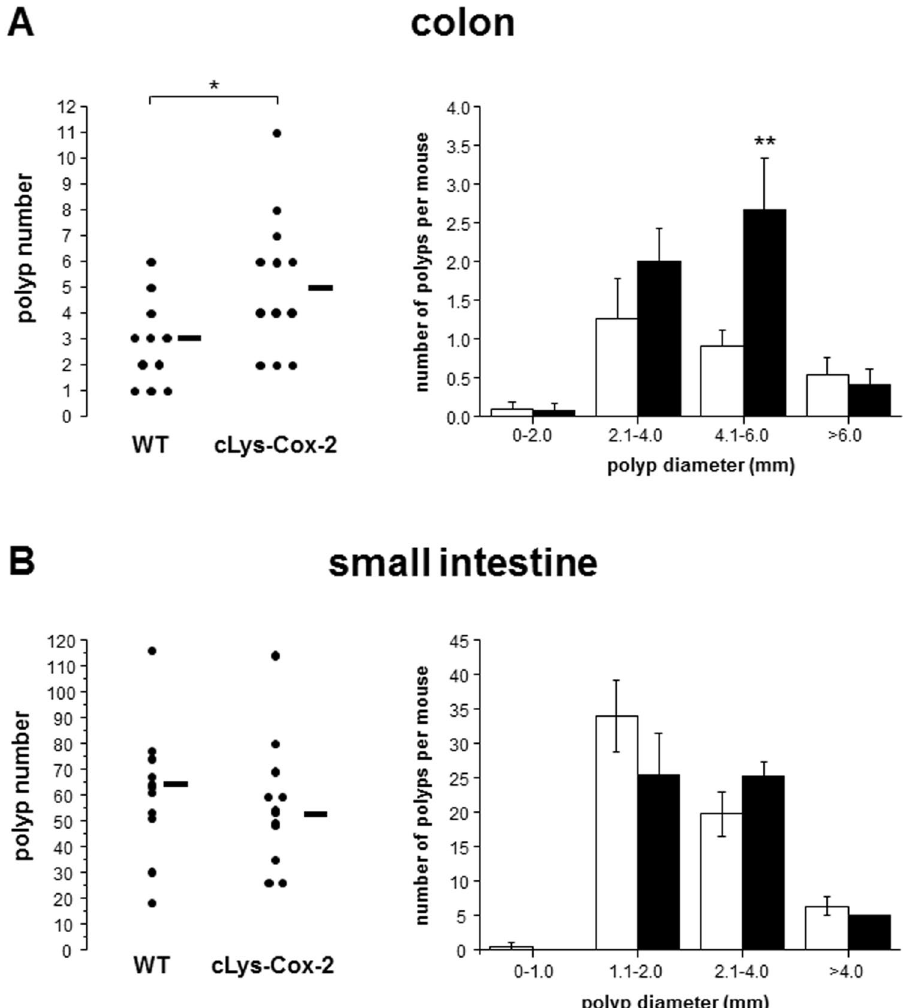
Figure 3. Colonic tumour number and size are increased in cLys-Cox-2 x Apc Min/ + mice. Colonic ( A ), but not SI ( B ), tumour multiplicity and size are increased in cLys-Cox-2 x Apc Min/ + mice compared with non-transgenic controls. Post-mortem intestinal phenotype analysis was performed at 100-110 days of age by one observer blinded to genotype. Dots represent individual tumour numbers for 11 non-transgenic and 12 transgenic animals. Lines represent median values. Columns and bars represent the mean and SEM number of tumours in different size categories from non-transgenic (empty) and transgenic (shaded) Apc Min/ + mice. * P ≤ 0.03. ** P =